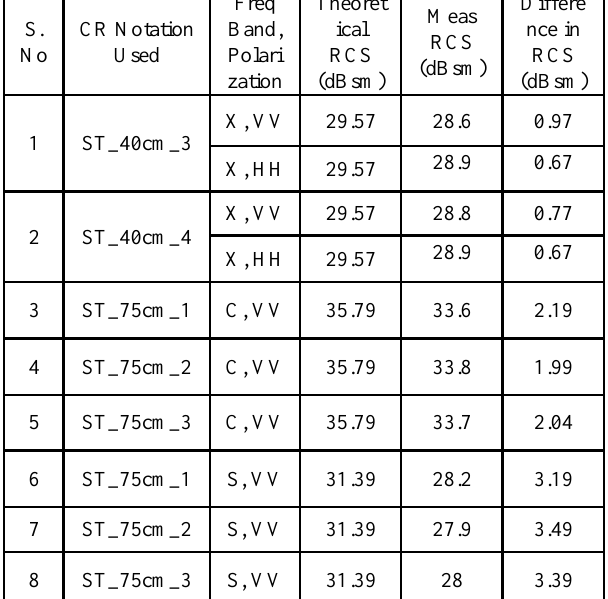
Table 2: Summary of RCS measurements for Square Trihedral corner reflectors at X, C and S bands